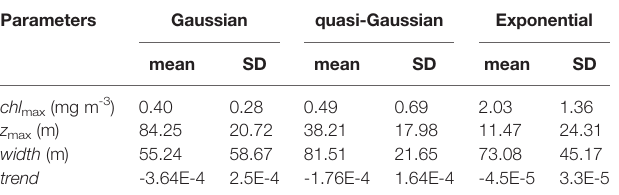
TABLE 1 | Statistics for the shape-dependent parameters of the different types of Chl-a vertical pro fi les in the Mediterranean Sea. Parameters Gaussian quasi-Gaussian Exponential mean SD mean SD mean SD chl max (mg m -3 )